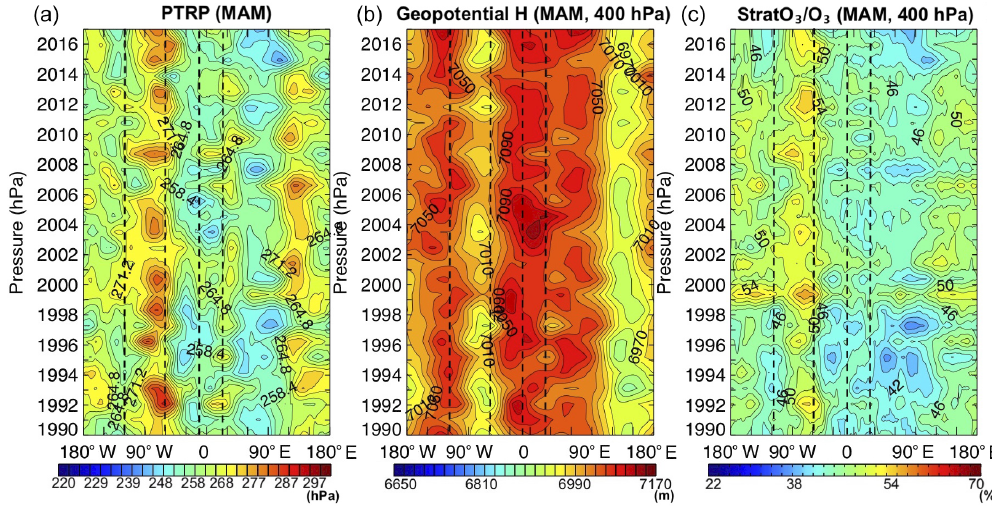
Figure 8. Latitudinal average between 30 and 80 ◦ N of (a) the tropopause pressure, (b) the geopotential height at 400hPa and (c) the StratO 3 / O 3 ratio at 400hPa along each longitude from 180 ◦ W to 180 ◦ E from 1990 to 2016 in spring (MAM). Dashed lines indicate the longitudinal range for the North American region (120–60 ◦ W) and the European region (10 ◦ W–26 ◦